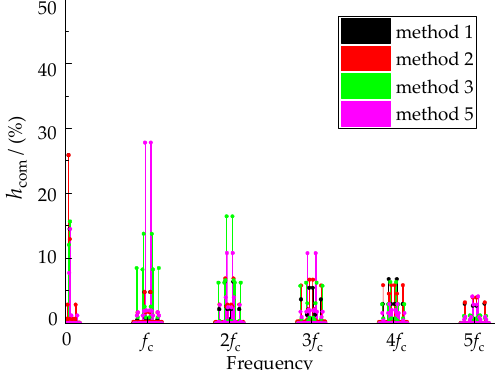
Figure 13. Spectrum of the common-mode components at m = 0.7.